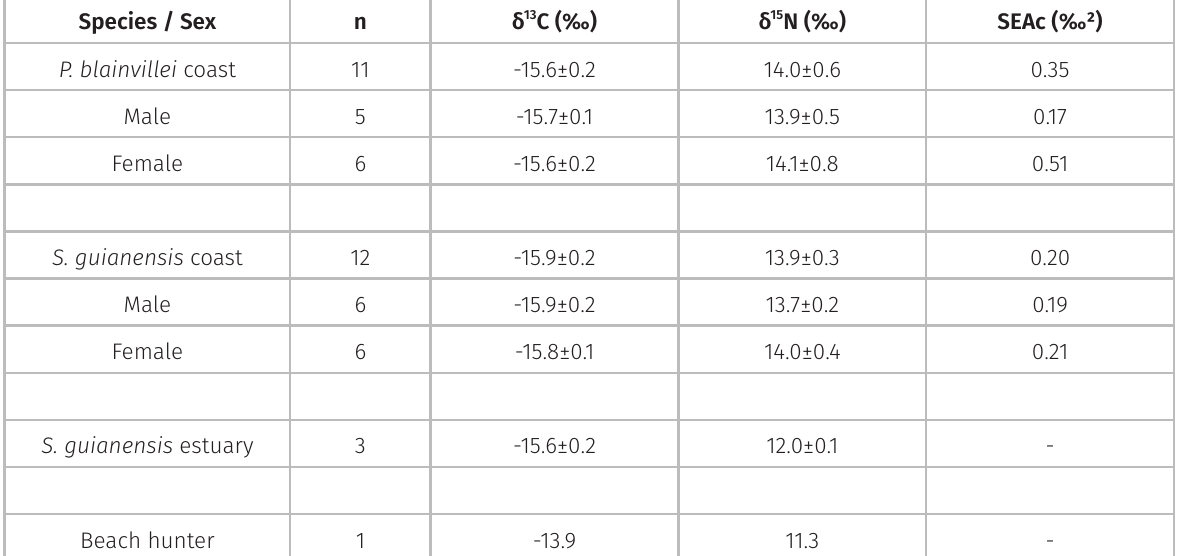
Table I. Sample size (n), mean values ± standard deviation of δ 13 C and δ 15 N and ellipse area (SEAc) for sampled Guiana ( Sotalia guianensis ) and franciscana ( Pontoporia blainvillei ) dolphins in Southeastern Brazil from 2011 to